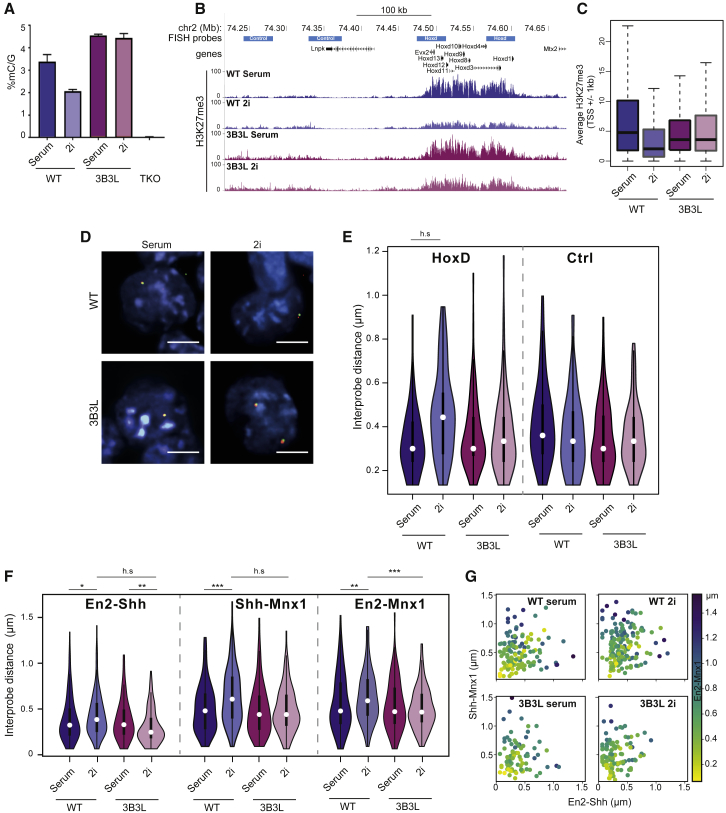
Maintenance of the Epigenetic and 3D Landscape in 2i(A) DNA methylation measured by mass spectrometry showing global levels of methylated cytosine in WT and 3B3L cells under serum/LIF and 2i/LIF conditions (as well as negative control TKOs, which lack all the active DNMTs; Tsumura et al., 2006). Values represent the percentage of methylated cytosine normalized to total guanine. The mean of two technical replicates is shown, with error bars representing the standard deviation of the mean.(B) UCSC genome browser screen shot at the HoxD locus showing H3K27me3 ChIP-seq in WT and 3B3L cells under serum/LIF and 2i/LIF conditions. Data for wild-type (WT) cells are from Marks et al. (2012). Data are binned into 200-bp windows and normalized by total read count with reads from matching input samples subtracted.(C) Boxplots representing average H3K27me3 signal on promoters (+/− 1 kb from transcription start site [TSS]) for all promoters in WT or 3B3L cells under serum or 2i conditions.(D) Representative images of nuclei after FISH with probes for HoxD from WT and 3B3L cells grown in serum or 2i. Scale bars represent 10 μm.(E) Violin plots showing distribution of inter-probe distances at the HoxD and a control (Ctrl) locus for WT J1 and 3B3L cells cultured in serum/LIF and 2i/LIF. h.s. = p < 0.0001. Biological replicate for 3B3L cells, and data for 3A3L cells are in Figure S5.(F) Same as in (E), but for probes to En2, Shh, and Mnx1; ∗ p<0.05, ∗∗ p<0.01, ∗∗∗ p<0.001 and h.s. p<0.0001.(G) Scatterplots showing individual measurements for data in (F), with two distances shown along the axes and one (En2-Mnx1) color coded.